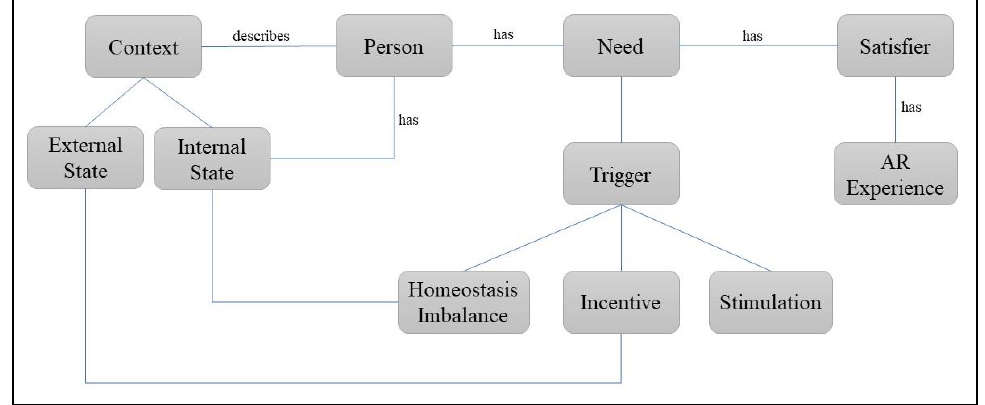
Figure 4. Conceptual model of augmented reality for human needs [39].